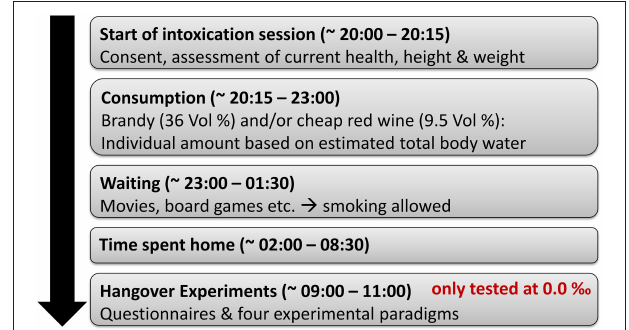
FIGURE 1 | Illustration of the hangover induction procedure. In order to induce alcohol hangover symptoms, we invited our participants to the laboratory on Friday or Saturday evening at 20:00. After obtaining written consent, a quick assessment of any recent health concerns, height and weight, an individually determined amount of alcohol (2.6375g of alcohol per estimated liter of body water) was consumed on a full stomach from ∼ 20.15 to 23:00. Until 01:30, participants were kept in the laboratory and asked to provide BAC measures in half-hour intervals, starting 30min after their last sip of alcohol. Participants were then brought home via taxi services and invited to show up in the laboratory at 09:00 the next morning for the hangover appointment. The data collection of the hangover appointment was however not started before participants had reached a BAC of 0.00 ‰